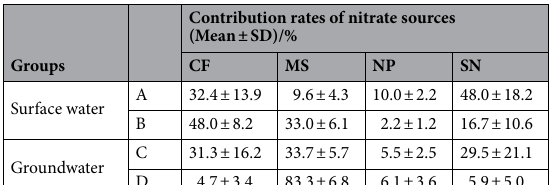
Table 2. Average contribution rates and deviations of nitrate sources in four water samples groups.